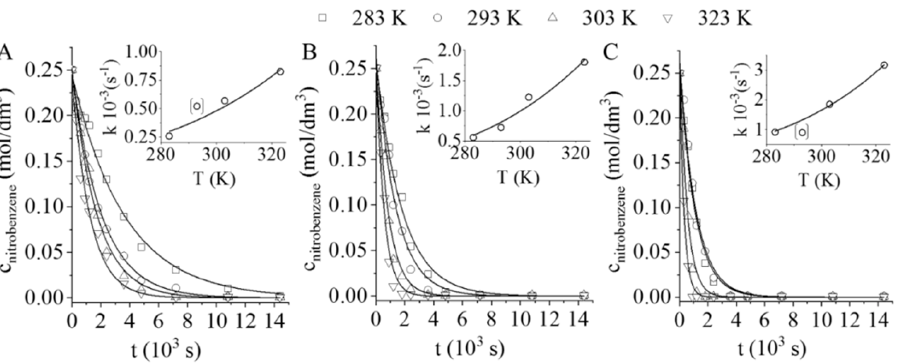
Figure 5. Nitrobenzene conversions vs. time of hydrogenation and the Arrhenius plots using Pd/GCF ( A ), Pd/GCF-AC1 ( B ), and Pd/GCF-AC2 ( C ) catalysts.